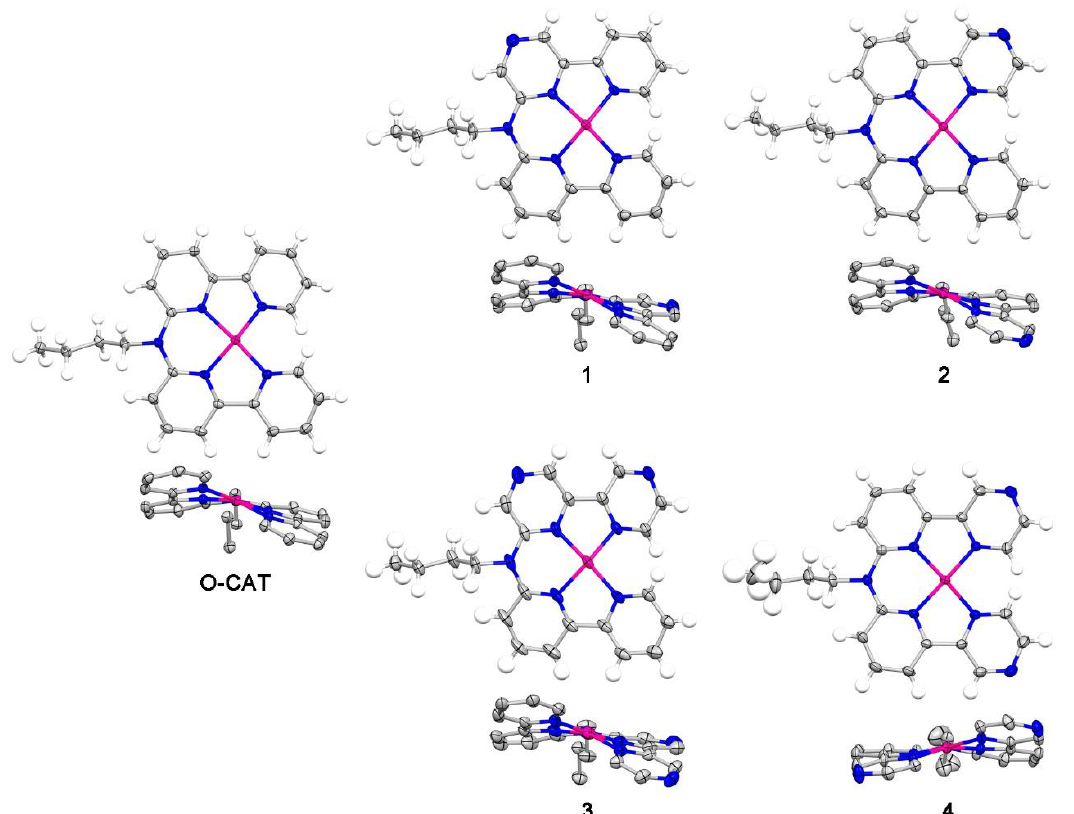
Figure 2. Crystal structures of O-CAT and 1 – 4 depicting a view of each macrocycle from the top and from the open end of the complex. Ellipsoids are depicted at 50% probability. Atom labels: carbon, gray; nitrogen, blue; cobalt, magenta. Co(II)-coordinated solvent molecules, disorder, and ClO 4 − counteranions are omitted for clarity. Hydrogen atoms are removed from the end-on view for clarity.